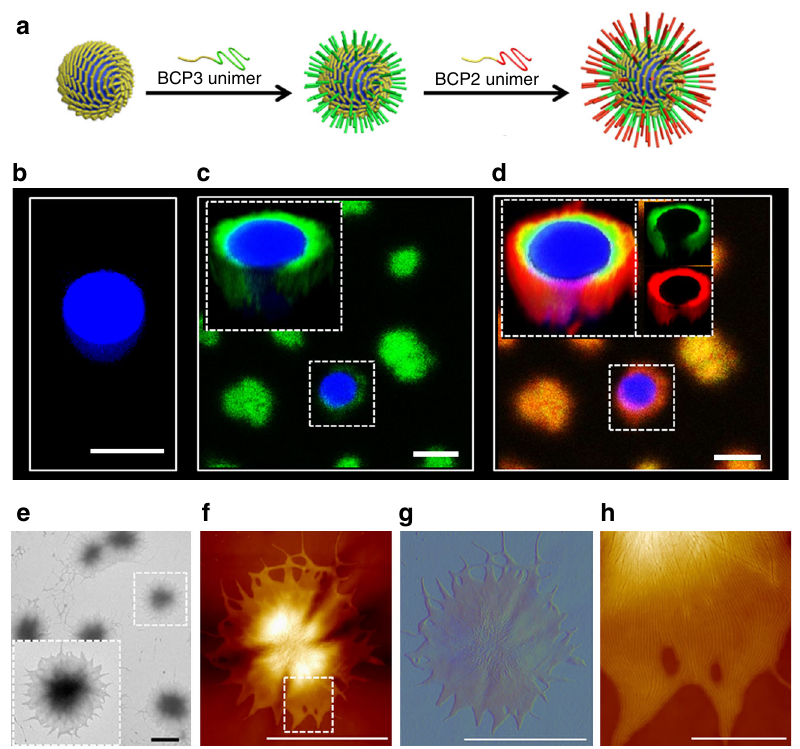
Fig. 3 Membrane engineering of PFS 25 - b -PMVSCOOH 245 colloidosomes by epitaxially driven micelle elongation. a Schematic representation showing structural and compositional elaboration of crosslinked BCP1 colloidosomes by a two-step sequence of epitaxial attachment of BCP1/BCP3 ( green ) and BCP1/BCP2 ( red ) unimers at the membrane surface. b – d Confocal fl uorescence microscopy images of crosslinked colloidosomes prepared by interfacial assembly of Cascade blue – dextran-containing size-speci fi c ( L n = 882 nm, L w / L n = 1.01) BCP1 cylindrical micelles, and recorded before ( b ) and after addition of BCP1/BCP3 unimers ( c ), and after addition of BCP1/BCP2 unimers to the BCP1/BCP3-treated microcapsules ( d ). Epitaxial elongation of the BCP1 cylindrical micelles in the native membrane gives rise to successive shells of green and red fl uorescence around the blue fl uorescent interior of the colloidosomes. Insets show Z -stack images. Samples were dispersed in isopropanol at a colloidosome concentration of 0.1 mg mL − 1 and unimer/ colloidosome mass ratio of 7:5. Under these conditions, the dextran ( M w = 10,000 Da) was retained within the interior of the colloidosomes. In c and d the colloidosomes exhibit different colours in the low-magni fi cation images as a result of their position relative to the confocal plane. e Representative TEM image showing hair-like texture on partially collapsed BCP1 colloidosomes after stepwise addition of BCP1/BCP3 and BCP1/BCP2 unimers; inset shows high-magni fi cation view. f , g PeakForce AFM topography f and corresponding error signal (emphasises the edges of individual micelles) g of partially collapsed hairy colloidosome prepared as above. h High-resolution AFM topography of area delineated by the dashed box in f showing epitaxially elongated cylindrical micelles within the modi fi ed colloidosome membrane. The micelles are co-aligned and closely packed, and the length of the growth extension is between 1 and 2 μ m. Samples were prepared at a unimer:colloidosome mass ratio of 7:5. Scale bars in b – g , 5 µ m. Scale bar in h , 1 µ